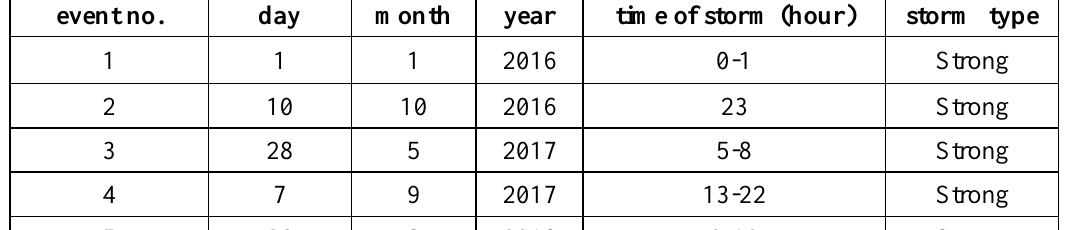
Table 1: Strong geomagnetic storms occurred through the years 2016-2018. event no.